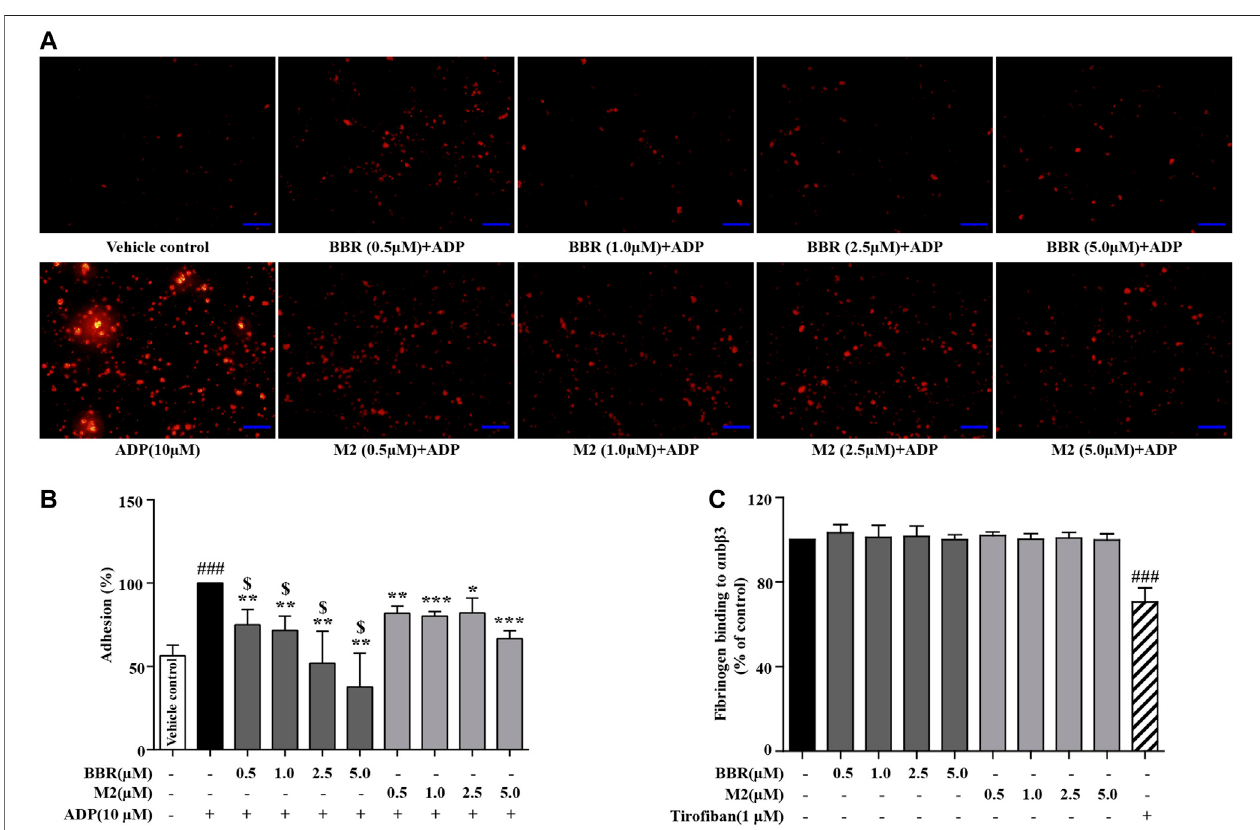
FIGURE 3 | Effects of BBR and M2 on the binding of fi brinogen to the platelets and puri fi ed α IIb β 3 in vitro . The WPs were pretreated with the vehicle control (0.1% DMSO),BBR,orM2atindicatedconcentrationsfor10 minandstimulatedwith10 μ MofADPfor10 min. (A) Theplateletswereincubatedwith fi brinogencoatedinglass coverslips and stained with TRITC – phalloidin. Images were taken using a fl uorescence microscope and are presented as representative of three independent experiments( × 400,scalebar (cid:1) 100 µm). (B) Theplateletswerestainedwithcalcein-AMandincubatedinglasscoverslipscoatedwith fi brinogen.The fl uorescence intensitiesweremeasuredforthequanti fi cationofplateletadhesion,whichareplottedaspercentagesoftheADPgroup.Thevaluesareexpressedasmean ± SDofthree independent experiments. ### p < 0.001 vs that of the vehicle control group; * p < 0.05, ** p < 0.01, and *** p < 0.001 vs that of the ADP group. $ p < 0.05 vs that of the M2 group at the sameconcentration. (C) Fibrinogen was added to wells which were bound with puri fi ed α IIb β 3, together with the vehiclecontrol, at different concentrations of BBR, M2, or 1 μ M of tiro fi ban. After treatment, the residual fi brinogen was measured and plotted as percentages of the vehicle control. The values are expressed as mean ± SD of seven independent experiments. Statistically signi fi cant differences when compared with the vehicle control group are indicated by ### p < 0.001.